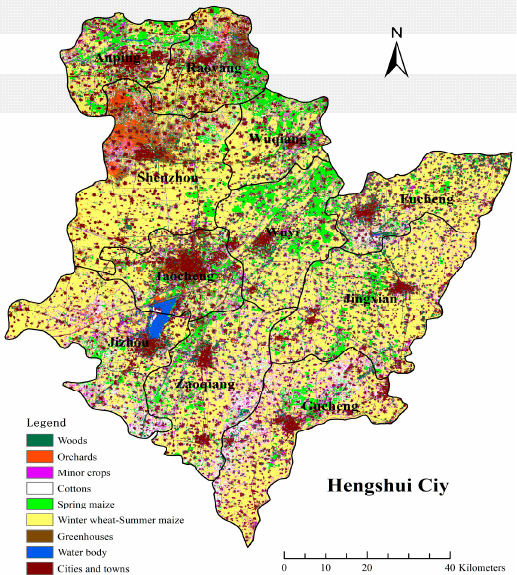
Figure 7. Classification results of different land cover and crops in Hengshui City in 2019.